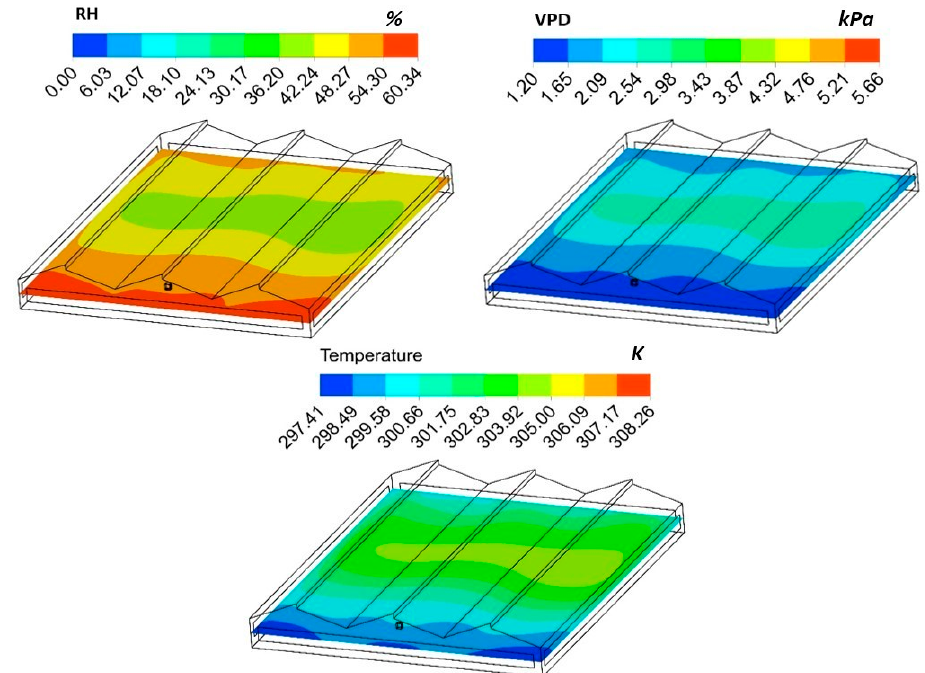
Figure 5. Distribution of RH (%), temperature (K), and VPD (kPa) in the greenhouse at 1.5 m height in scenario b, considering the mean monthly wind speed (1.59 m s − 1 ) during February.